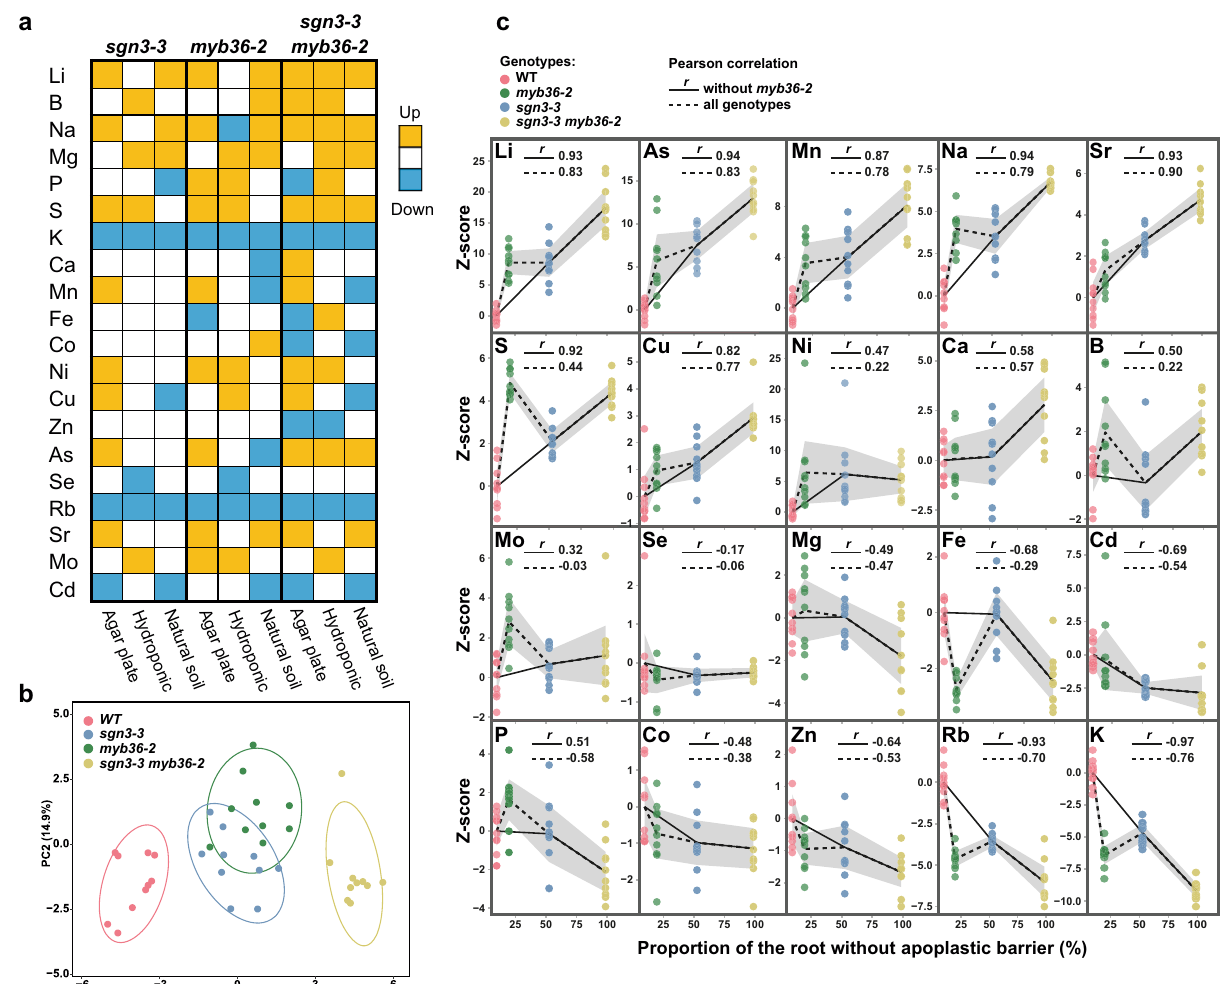
Fig. 5 Absence of endodermal apoplastic barrier triggers major ionomic changes. a Overview of ions accumulation in shoot of sgn3-3 , myb36-2 and sgn3- 3 myb36-2 mutants compared to WT using different growth conditions in agar plates (long day, n = 10 individual plants), in hydroponics (short day, n = 6 individual plants) and natural soil (short day, n = 18 for WT, n = 18 for sgn3-3 , n = 18 for myb36-2 and n = 13 for sgn3-3 myb36-2 ). Element concentration was determined by ICP-MS and is available in Supplementary Data 3. Colour code indicates signi fi cant changes in accumulation compared with the WT using a two-sided t -test ( p < 0.01). b Principal component analysis (PCA) based on the concentration of 20 elements in shoots of plants grown in